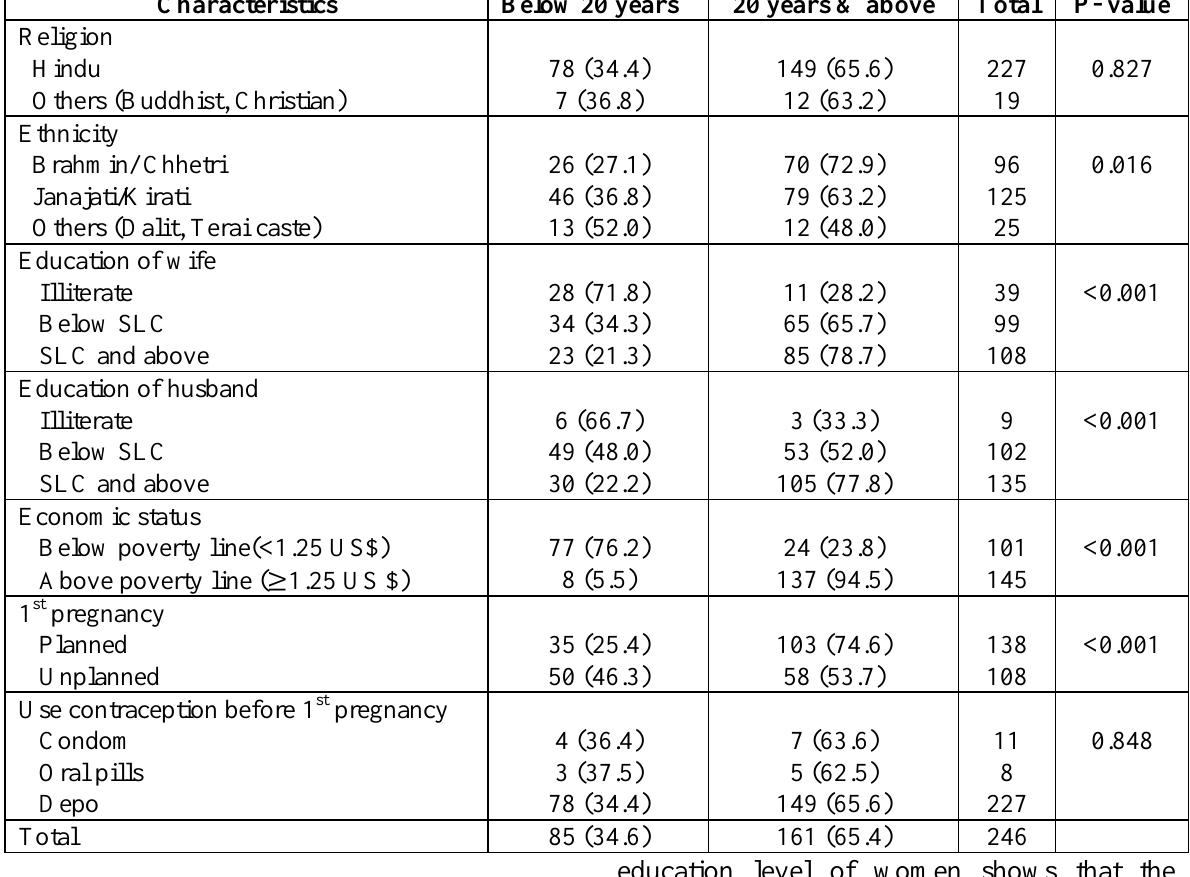
Table 2. Association between selected variables with age of 1 st pregnancy